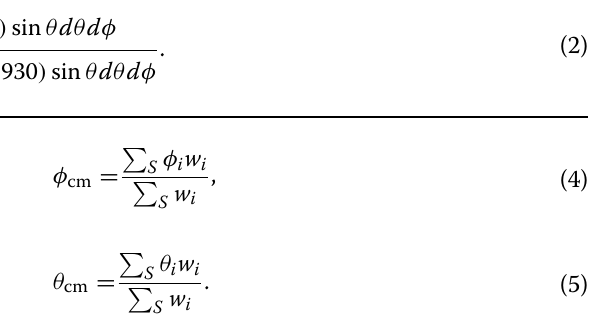
The summations in (4)–(5) are over the SAA area, either